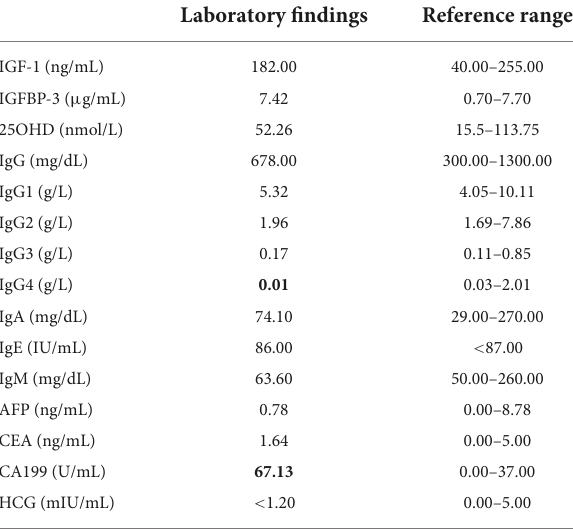
TABLE 1 Summary of laboratory findings.